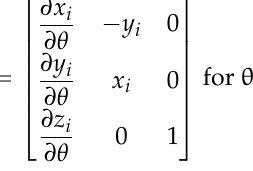
P . The Jacobian ( i c